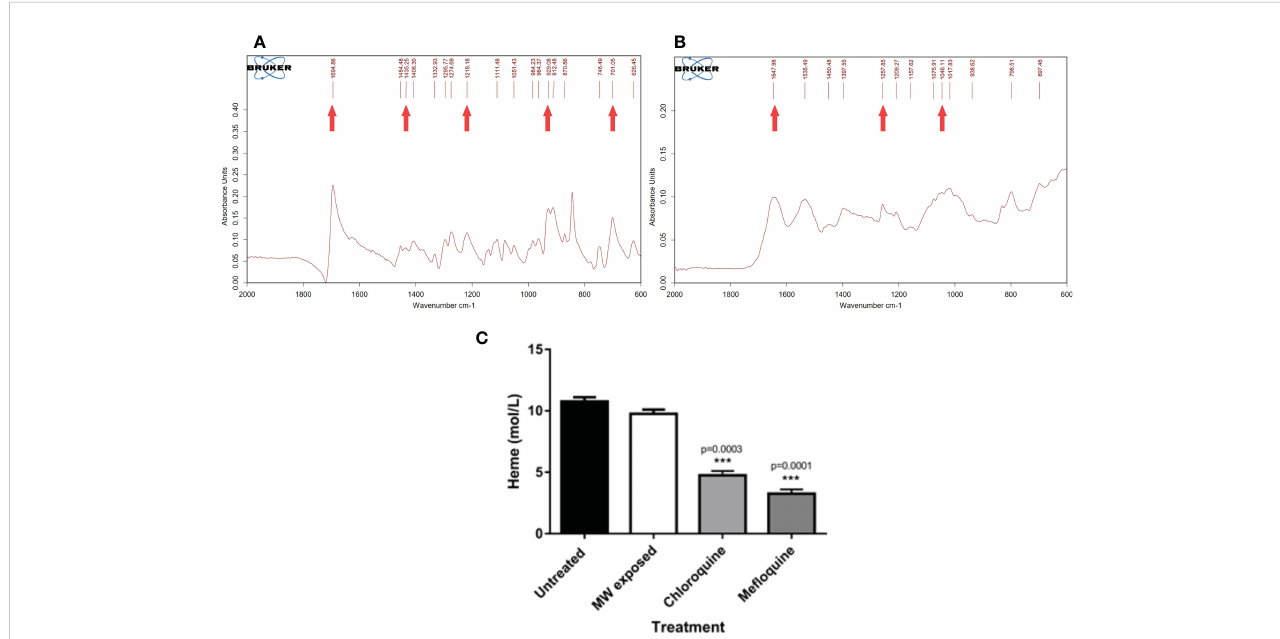
FIGURE 9 Effect of MW on the crystallization of haemozoin. A haemozoin formation assay based on the differential solubilities of haem and haemozoin was conducted in the presence of different agents by exposing infected erythrocytes to chloroquine, me fl oquine or MW. (A) FT IR pro fi le of haem from the samples and (B) FT IR pro fi le of haemozoin. Arrows point to the characteristic peaks of both molecules. (C) Comparison of the effect of different treatments in the production of haemozoin. The values are the means of triplicates of one representative experiment (n=3). One-way ANOVA analysis was used.